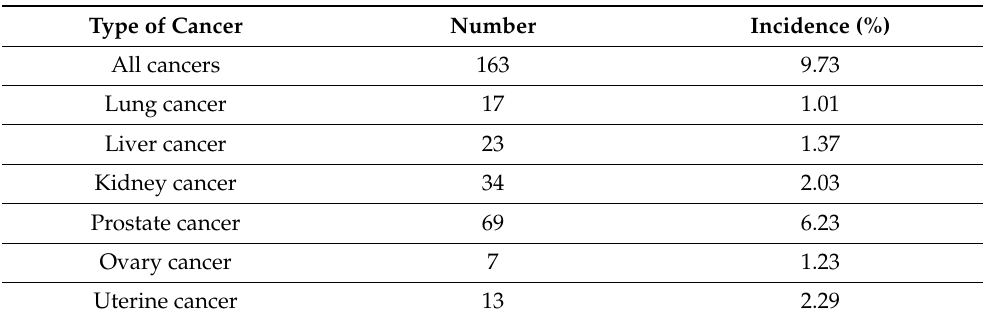
Table 4. Numbers and incidence of cancer among residents exposed to Agent Orange living in some of the provinces of South